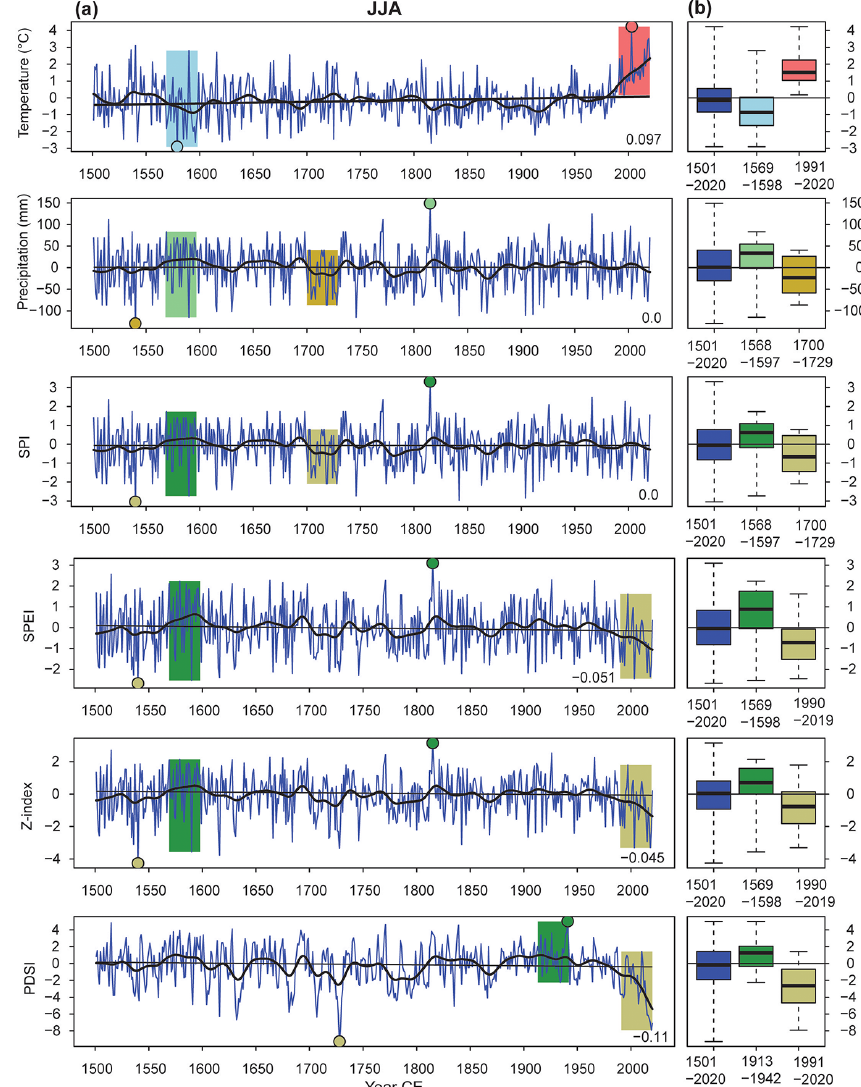
Figure 5. See text in Fig. 1;